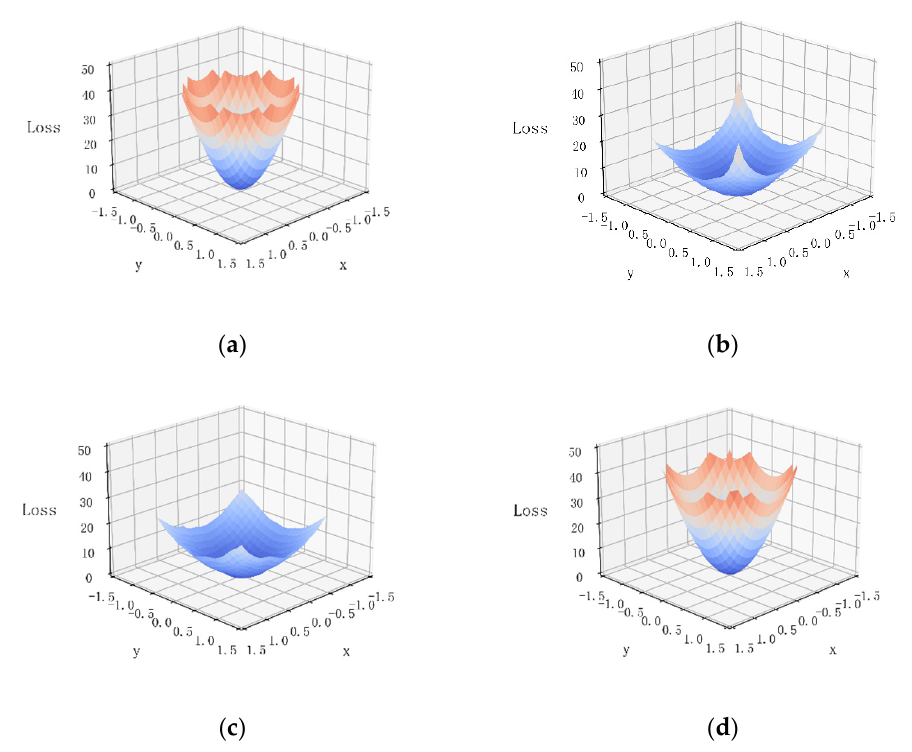
Figure 15. Loss landscapes. ( a ) ResNet, ( b ) BoTNet, ( c ) ViT and ( b ) ConViT.